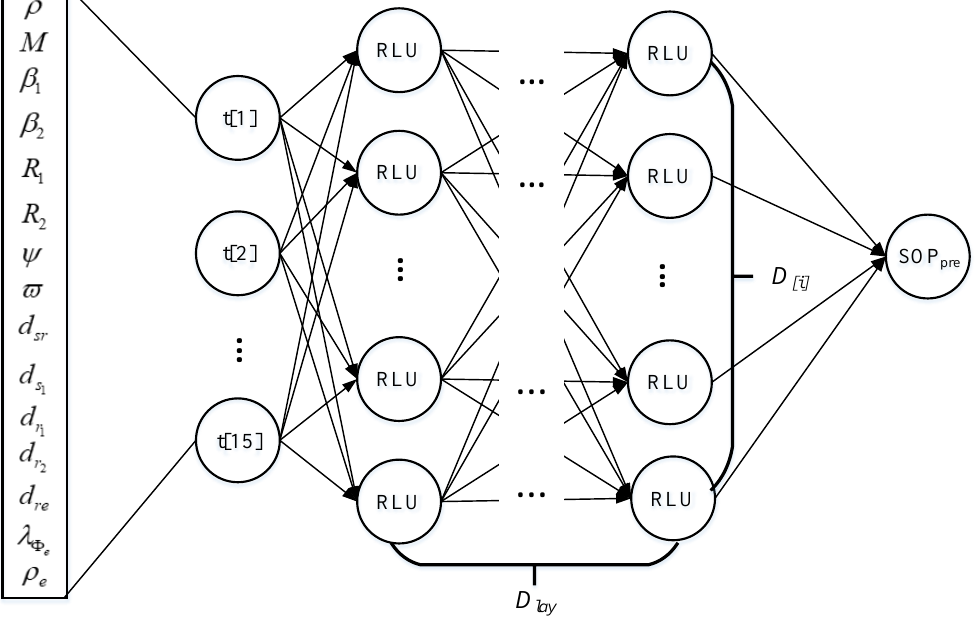
Figure 4. The configuration of DNN for the considered regression